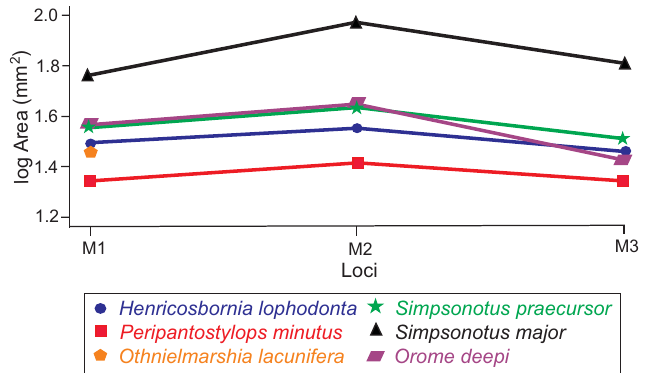
Fig. 5. Size comparison between members of Henricosborniidae and Orome deepi gen. et sp. nov.